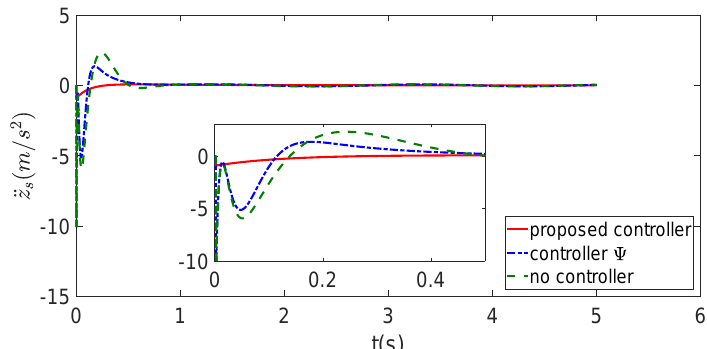
Figure 13. Vehicle body vertical displacement.